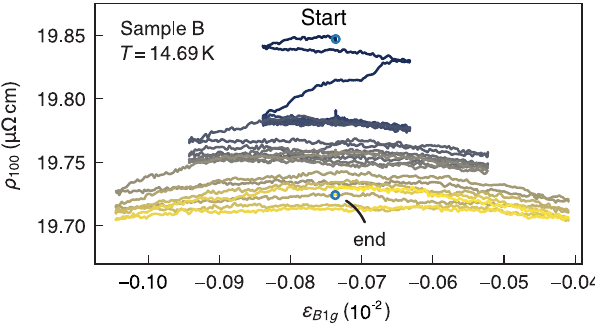
FIG. 10. Annealing twin boundaries out of the sample by ramping the applied strain.